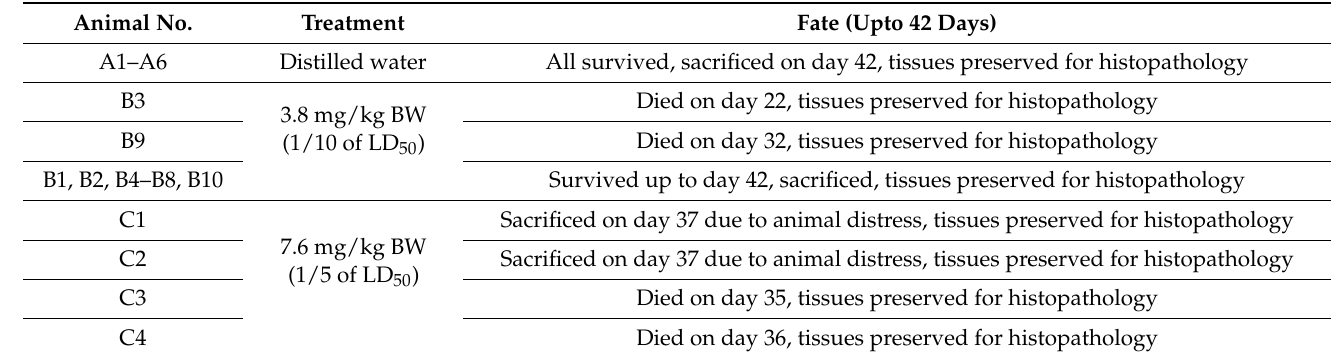
Table 2. Disposal of animals in subacute study ( n =